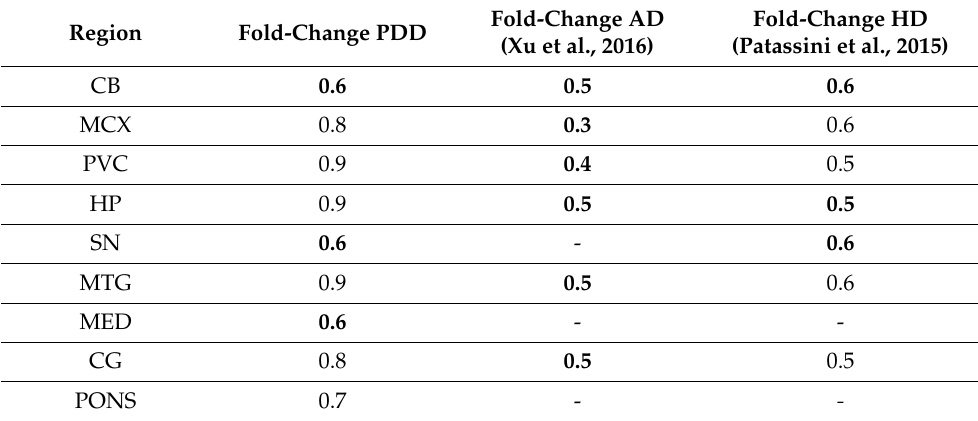
Table 3. Pantothenic Acid Concentrations in PDD Cases and Controls.